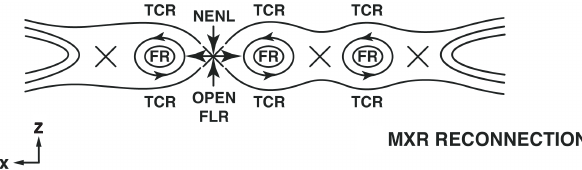
Fig. 33. Schematic representations of flux rope and TCR forma- tion under the action of multiple X-line formation. (Adopted from Slavin et al.,